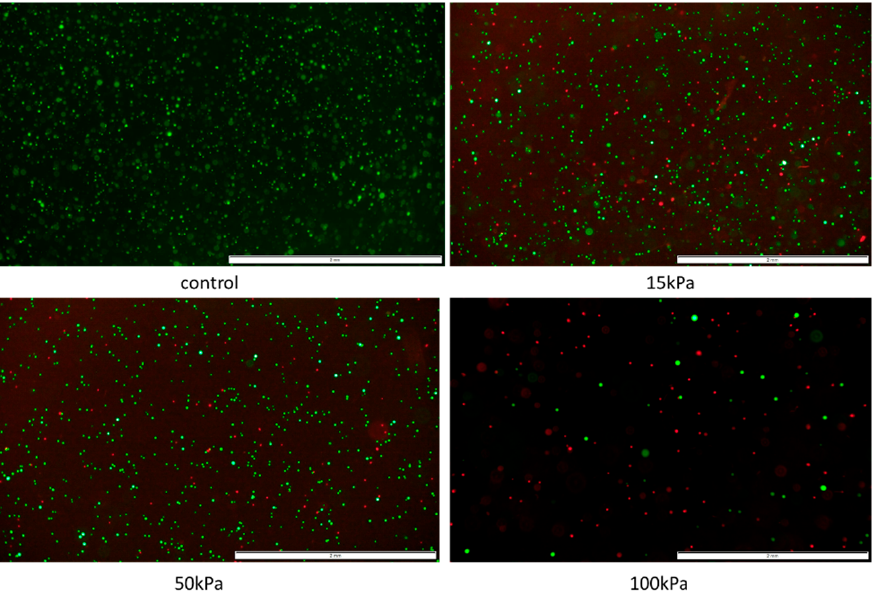
Figure 13. Pressure influence on endothelial cell line-BALB-5206 visualized by FDA/PI staining. Nozzle with inner diameter 0.2 mm; scale = 2mm.